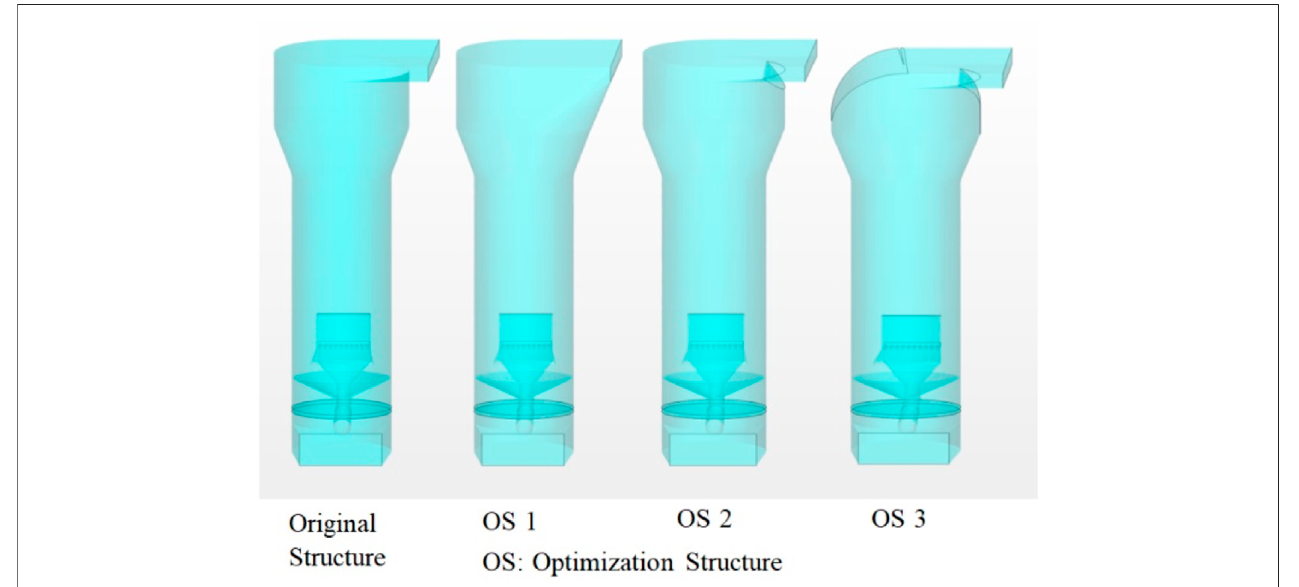
FIGURE 12 | Preliminary study of structural